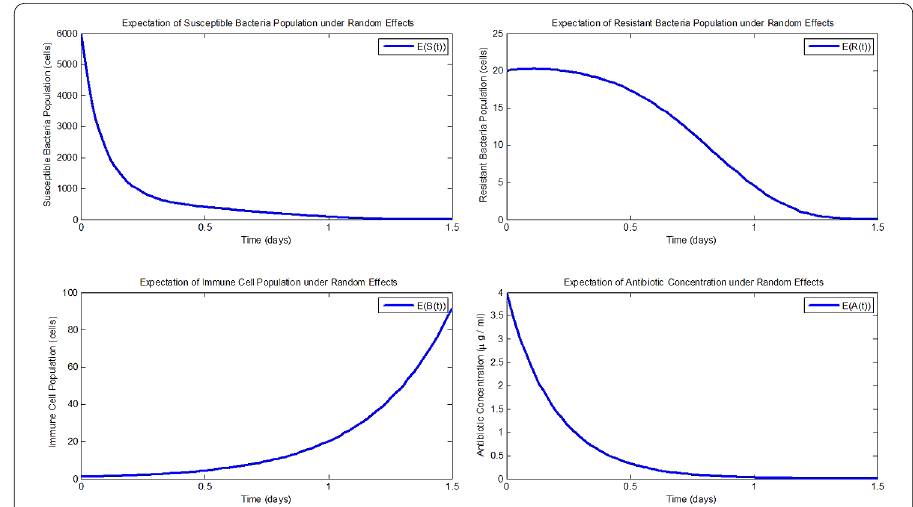
Figure 6 Expectations of the random model.